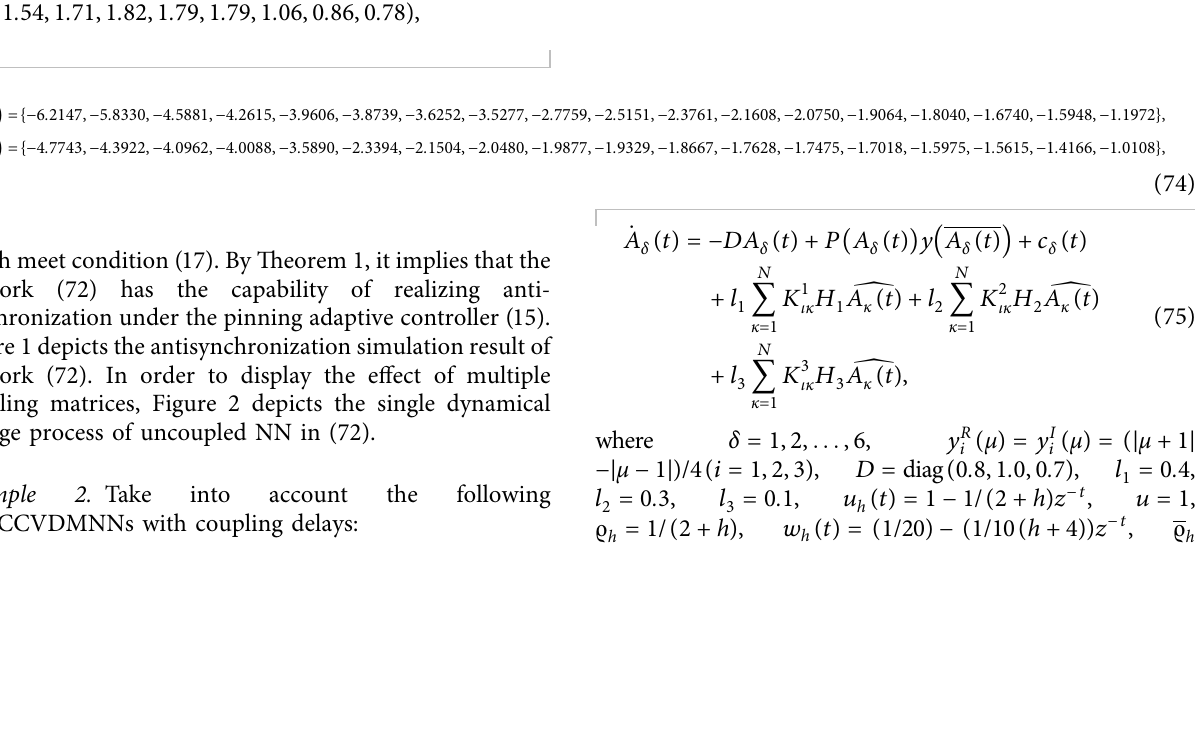
( t )‖ without pinned nodes, where ι � 1 , 2 , . .. , ι